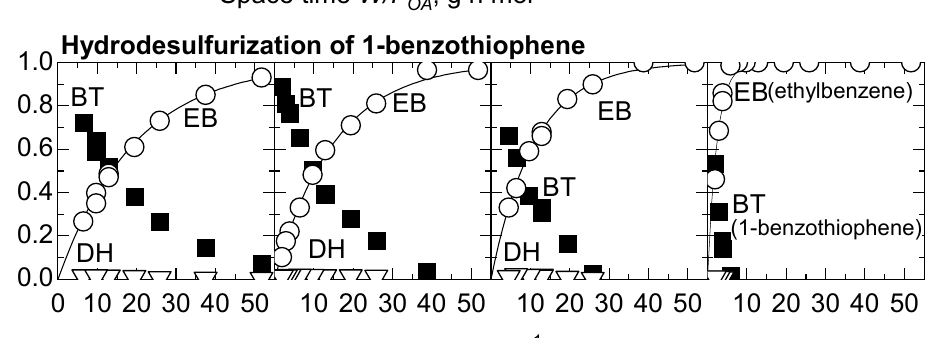
Figure 3. The formation of linear C 8 and C 7 hydrocarbons and ethylbenzene (EB) during parallel HDO/HDS of octanoic acid (OA) and 1-benzothiophene (BT) over the studied catalysts: solid lines—fitting of activity k HDO and k HDS by Equations (1) and (2), respectively.